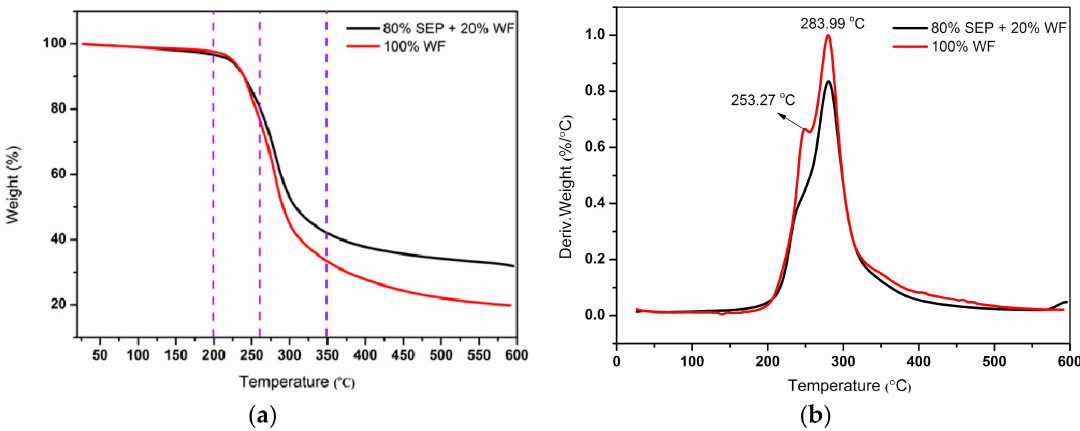
Figure 5. TG ( a ) and DTG ( b ) curves of UF resin with di ff erent fillers: Resin A1—100% WF + 0% SEP; Resin A5—80% SEP + 20%